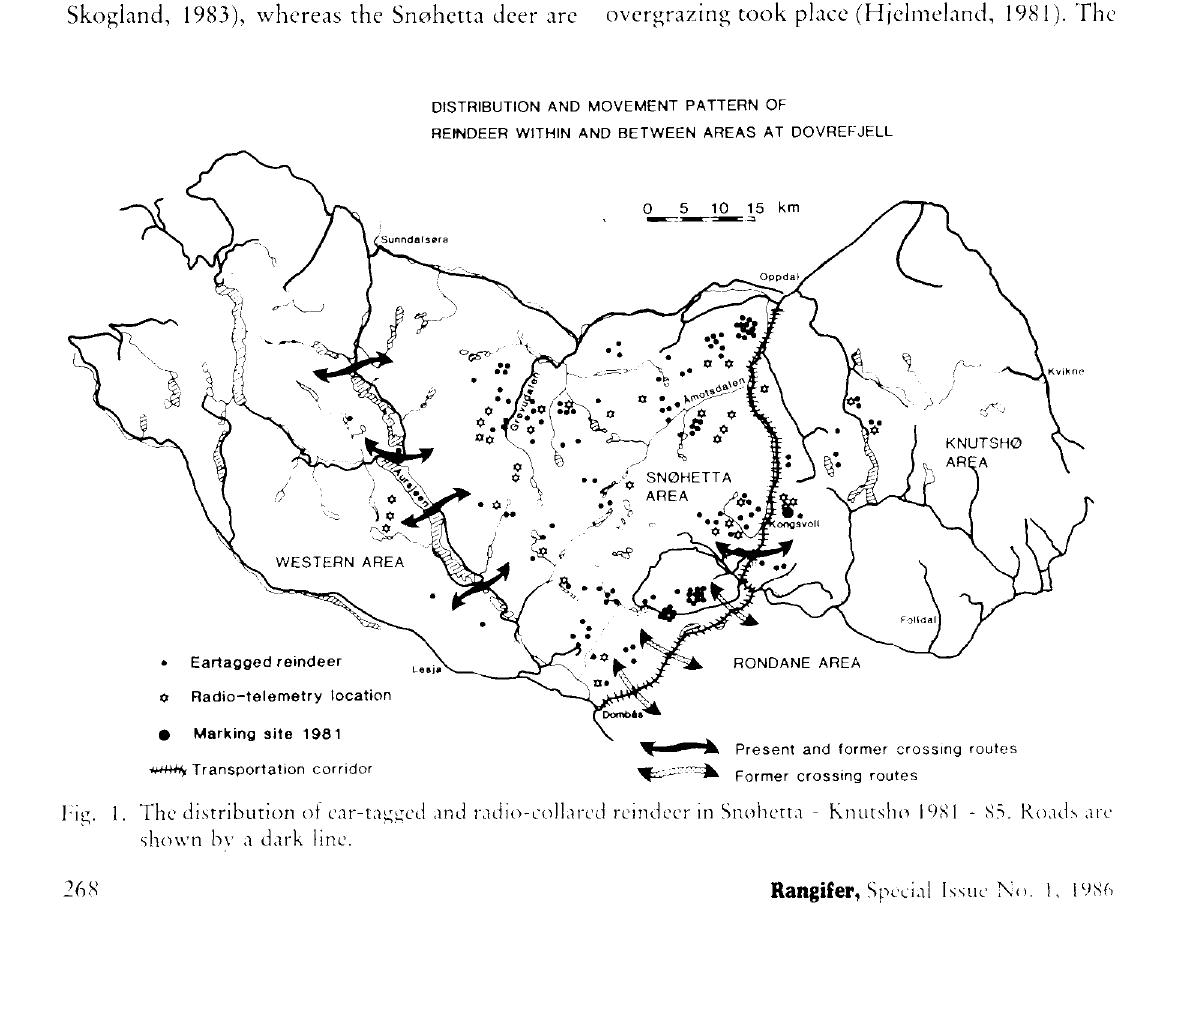
Fig. 1. The distribution of ear-tagged and radio-collared reindeer in Snohetta - Knutsho 1981 - 85. Roads are shown by a dark